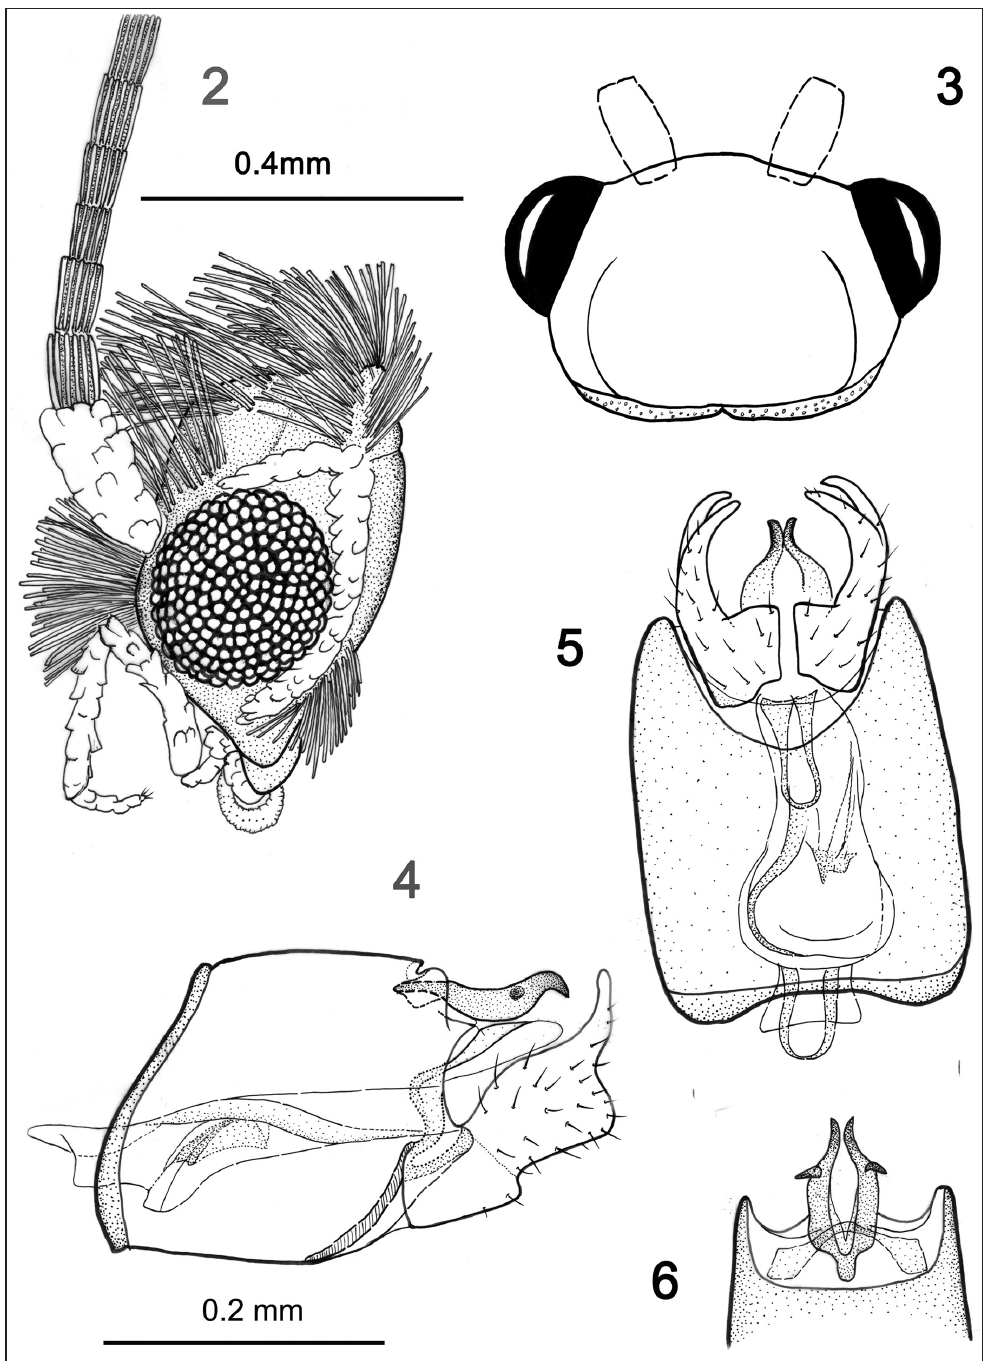
Figures 2–6. Catapterix tianshanica sp. n. 2. lateral view of head; 3. dorsal view of head capsule without vesti - ture; male genitalia: 4. lateral, 5. dorsal, 6.